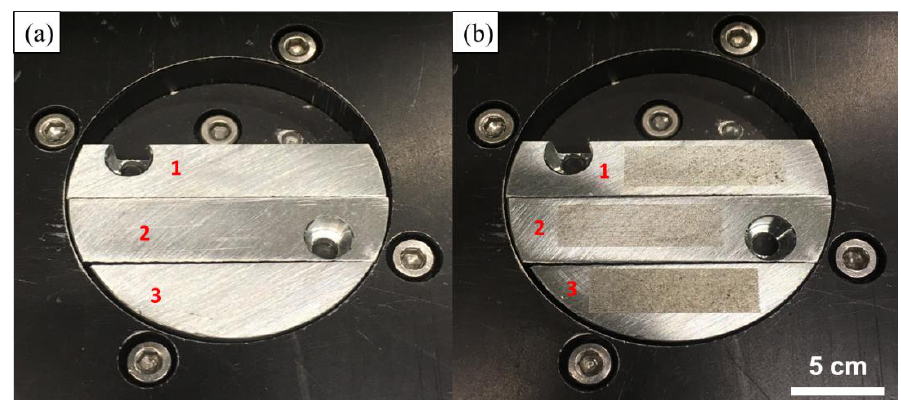
Figure 3. Pure Zn plates ( a ) before laser scanning and ( b ) after laser scanning.